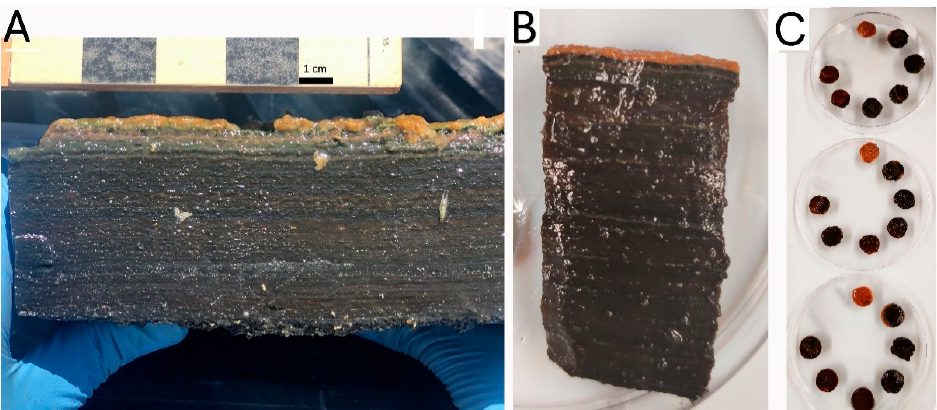
Figure 1. ( A ) Hypersaline microbial mat at the time of collection from a saltern in Guerrero Negro, Baja California Sur, México, scale at top is in centimeters, photo credit: José Q. García Maldonado, ( B ) Higher magnification image of a cross sectional view of a 1 cm diameter core showing the mat laminations, and ( C ) Sections of the core made at 1 mm intervals (3 replicate cores shown in 10 cm Petri dishes).